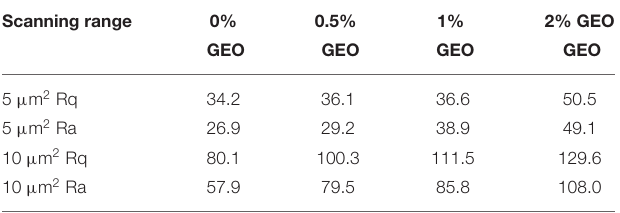
TABLE 3 | AFM roughness parameters of the cassava starch-based films. Scanning range